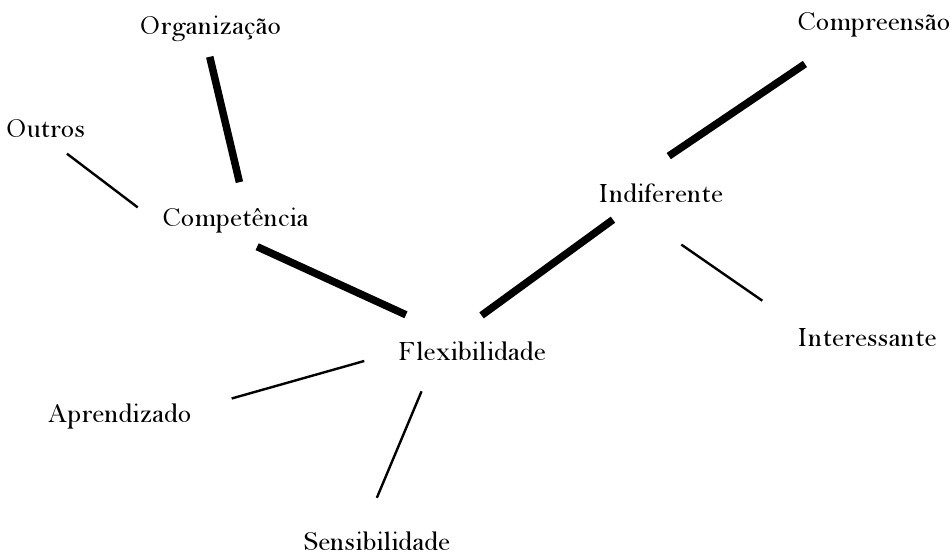
Figura 3 . Árvore máxima da caracterização do gerenciamento